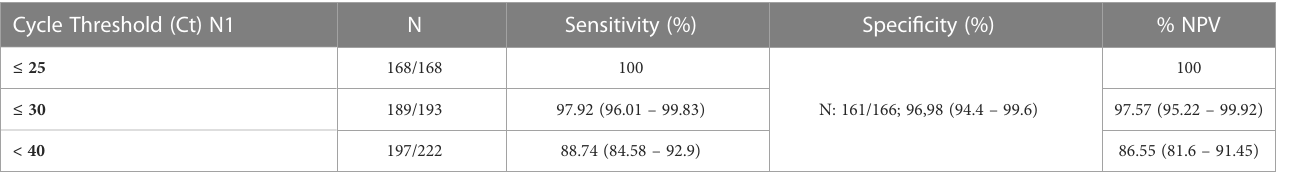
TABLE 1 Evaluation of the clinical performance of the RNA extraction free homogenization-based method for SARS-CoV-2 detection. Cycle Threshold (Ct)